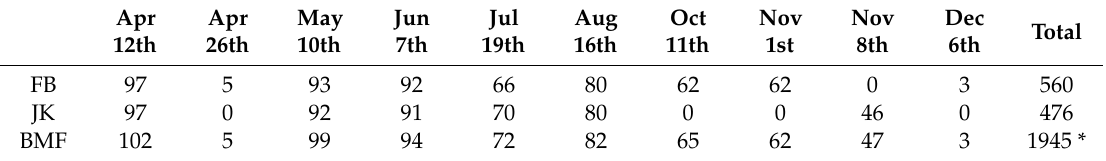
Table 1. Count of records from manual observers FB and JK, and the BodyMat F (BMF).